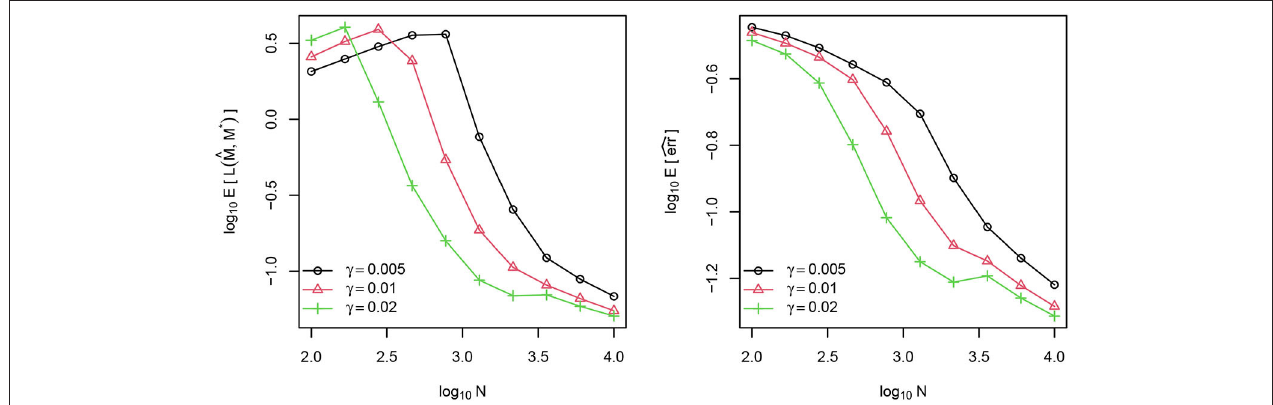
FIGURE 2 | Average Kullback-Leibler divergence (left) and average link prediction error (right) of ˆ M for different choices of N and γ .